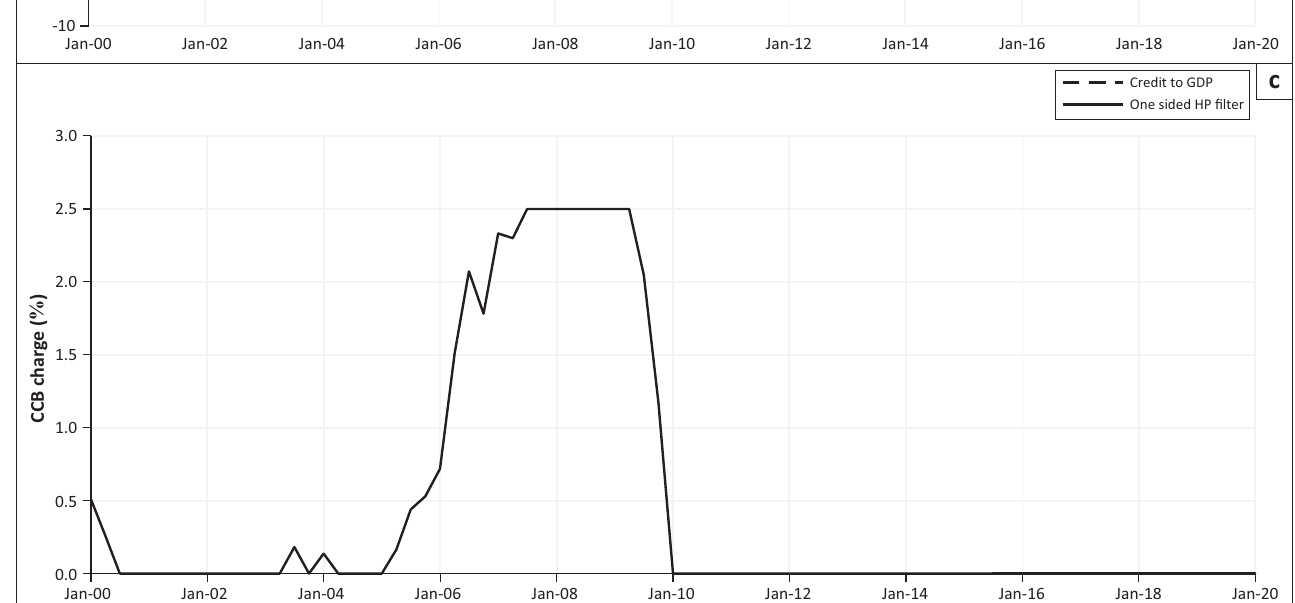
Note: The shaded area indicates the 2007 credit crisis period and illustrates how the (c) countercyclical capital buffer would have been at its peak during this period. FIGURE 7: (a) Credit/GDP and (b) Credit/GDP Gap for the South African economy and capital charges associated with the countercyclical capital buffer